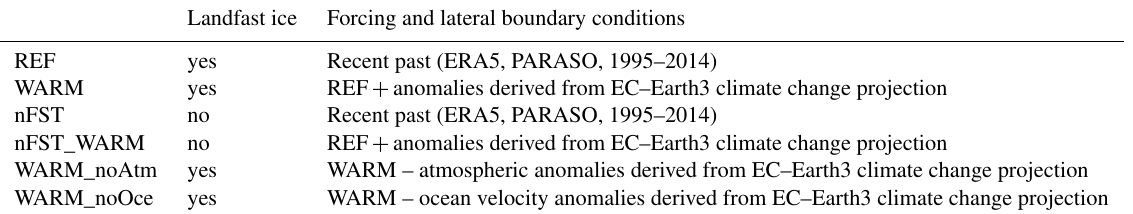
Figure 2. Vertical profiles of temperature (a) and salinity (b) after the bias correction on the continental shelf in front of the Totten ice shelf. Blue: CTD from Rintoul et al. (2016) (a1402). Black: as simulated in REF. Simulated profiles are taken at the same time and location as the CTD measurements. The observations have been collected in two locations: close to the TIS front and near the Dalton coastal polynya. The locations are denoted by white dots in the panel displayed in panel (b) . Table 1. Names and descriptions of the simulations used in this study. Landfast